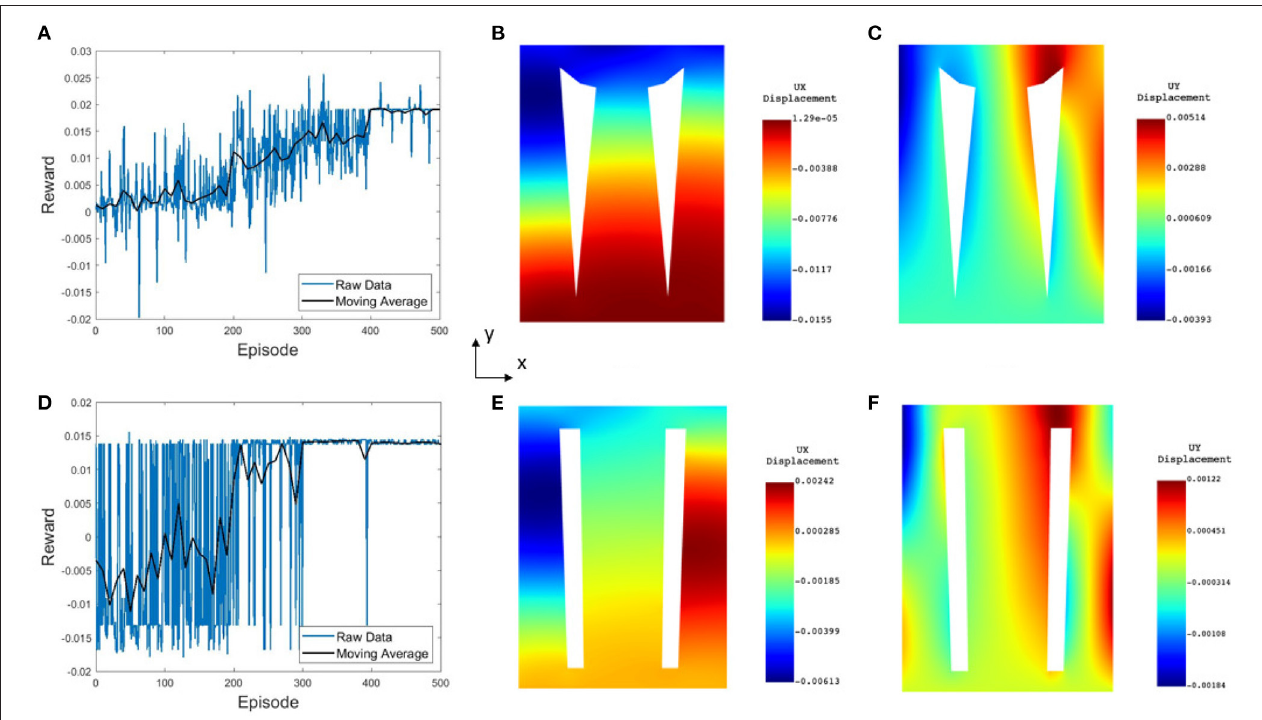
FIGURE 5 | Numerical computation results from FE-based optimizations for (A–C) the 8 action FE model and (D–F) the 4 action FE model. (A,D) Convergence of the reward, where steady state is achieved in 400 and 300 episodes, respectively. (B,E) Horizontal displacement contour map, where the maximal displacement on the top surface approaches 15.5 and 6 mm , respectively. (C,F) Vertical displacement